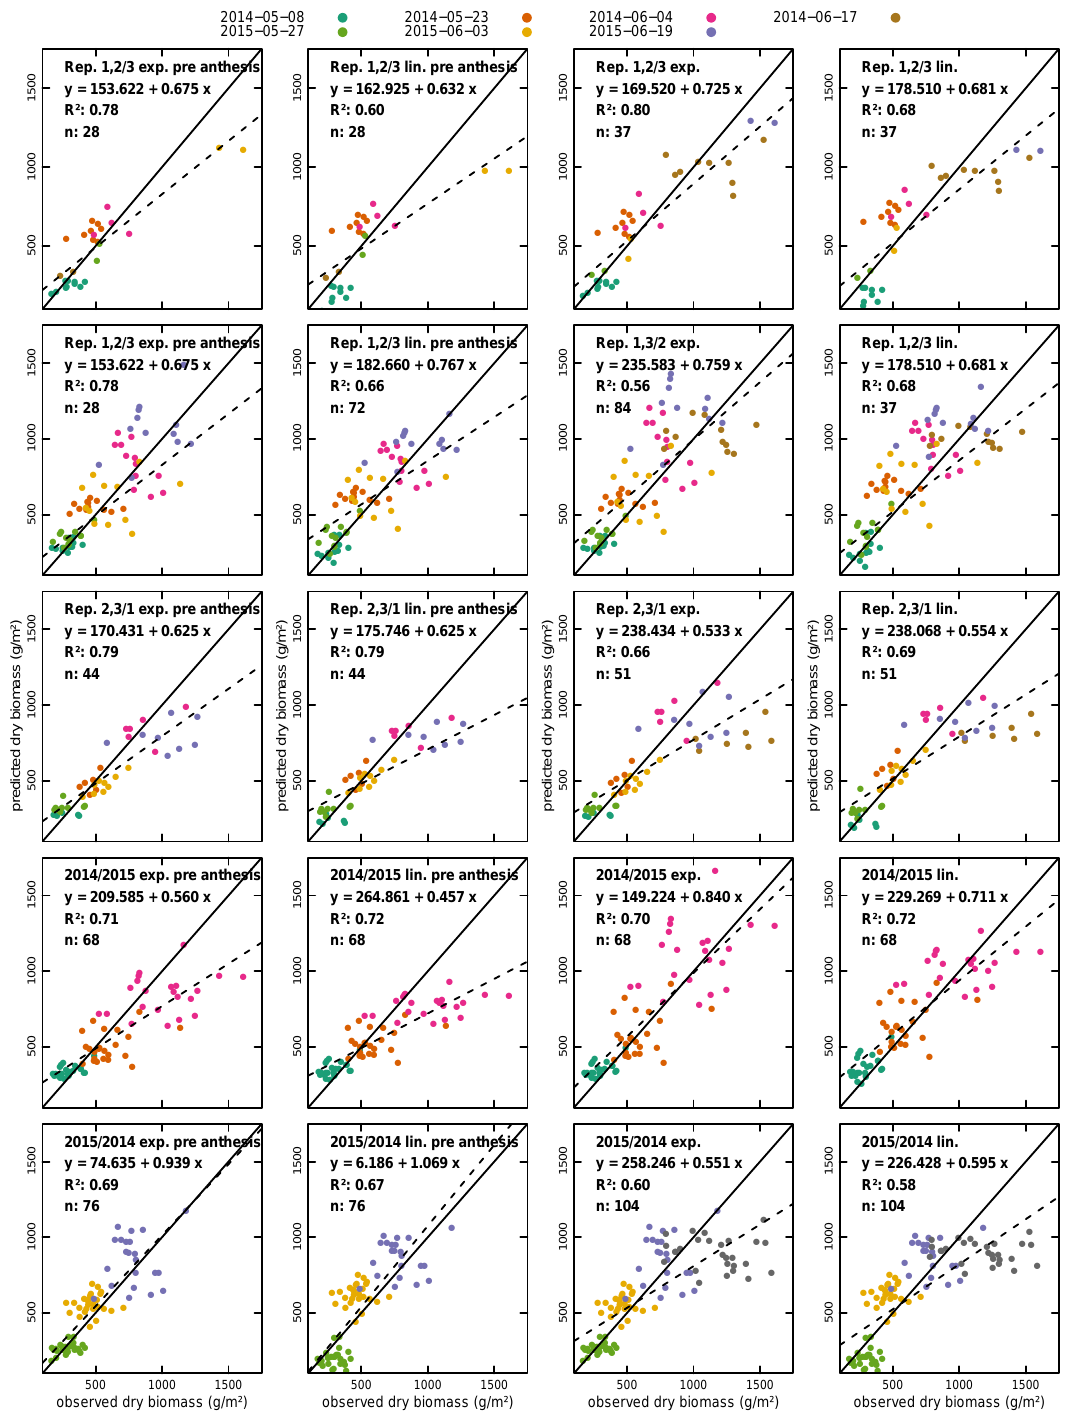
Figure 5. Observed vs. predicted dry biomass. The solid line is the 1:1 line, and the dashed line is the regression